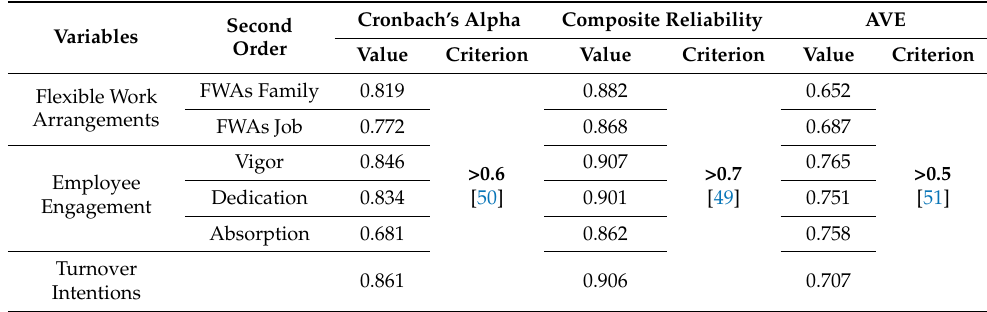
Table 7. Indicator reliability and construct reliability and validity. Variables